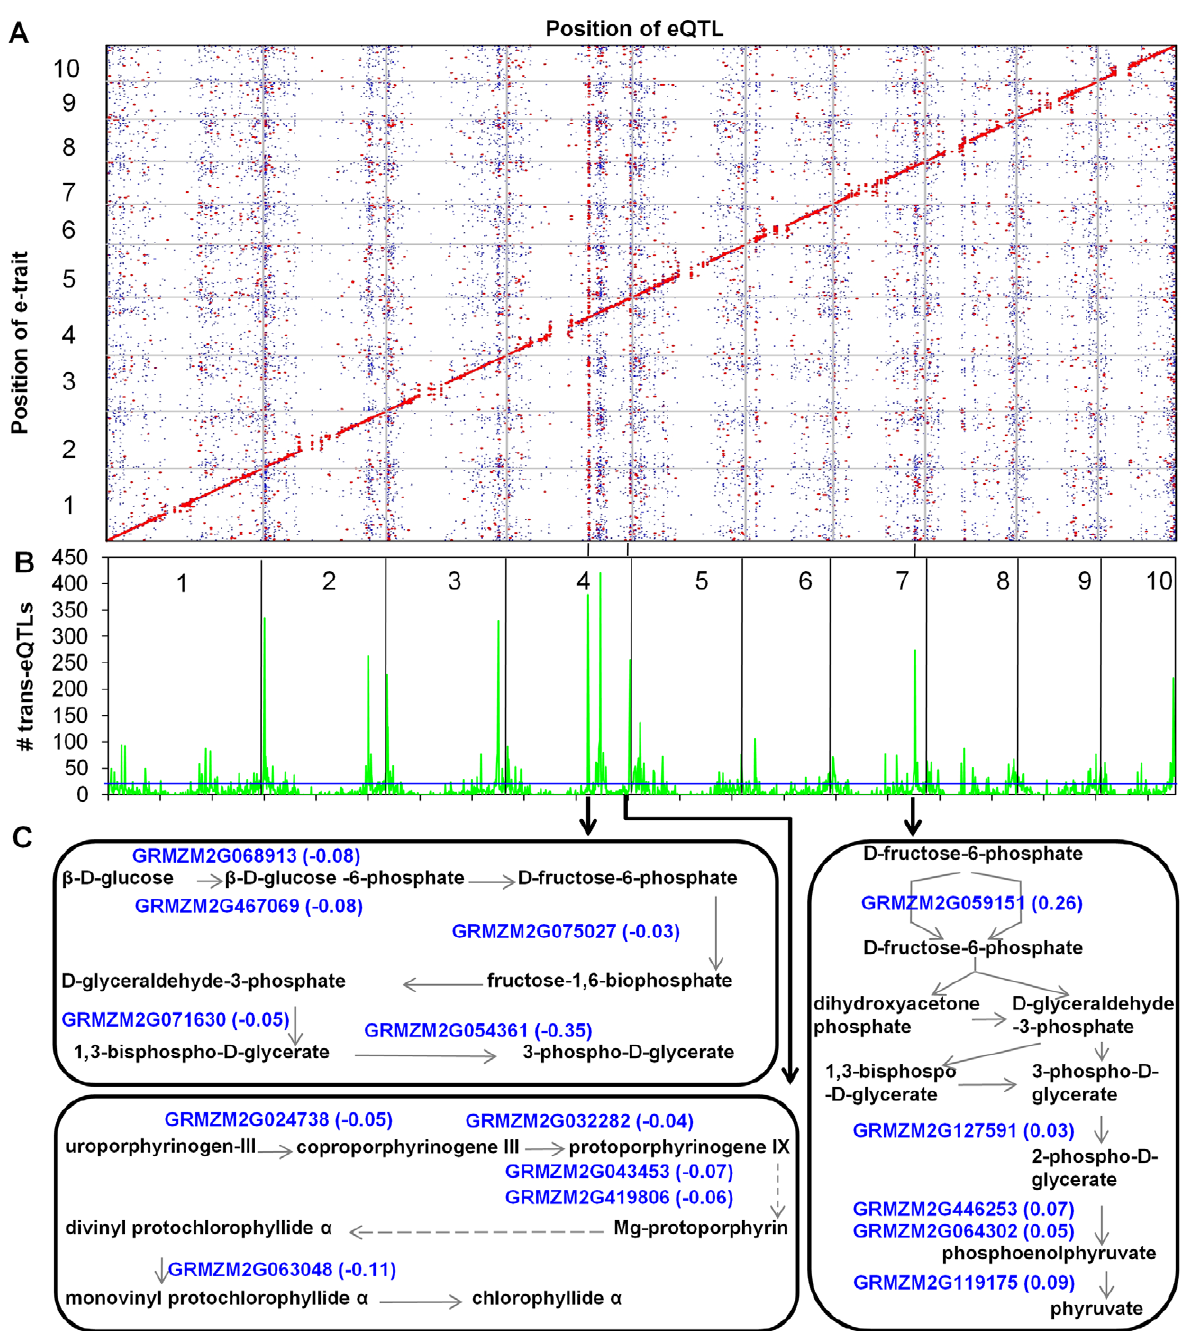
Figure 3. eQTL mapping, trans- eQTL hotspots, and pathways regulated by three trans- eQTL hotspots. (A) Genomic distribution of eQTLs identified in maize shoot apices. The x-axis indicates the genomic positions of eQTLs, while the y-axis shows the genomic positions of expressed genes (e-traits). The 10 maize chromosomes are separated by grey lines. The color of each point reflects the R 2 value. eQTLs with R 2 values greater than 20% were plotted in red, R 2 values less than 20% are indicated in blue. Totally, 30,774 eQTLs were divided into 11,504 ( , 37%) cis- eQTLs and 19,270 ( , 63%) trans- eQTLs. (B) The distribution of trans- eQTLs hotspots. The x-axis shows the genomic position of detected eQTLs (unit=1 Mb), while the y-axis represents the number of trans- eQTLs in each 1 Mb length genomic region. The horizontal blue line for eQTL hotspots indicates the threshold, which is represented by the maximum number of trans- eQTLs expected to randomly fall into any interval with a genome-wide P =0.01. The 10 maize chromosomes were divided by vertical black lines. The black lines linking (A) and (B) show several examples of the corresponding trans- eQTL hotspots in (A) and (B). A total of 96 trans- eQTLs hotspots were identified and 10 trans- eQTLs hotspots regulated at least 200 trans- eQTLs. (C) Genes regulated by three trans- eQTL hotspots are involved in specific metabolic pathways. The expression levels of these genes in pathways were regulated by trans- eQTLs located in these hotspots. The numbers beside these genes are the proportional changes which were the additive effects of the trans- eQTLs of Mo17 alleles divided by the population mean of expression levels of the target genes.